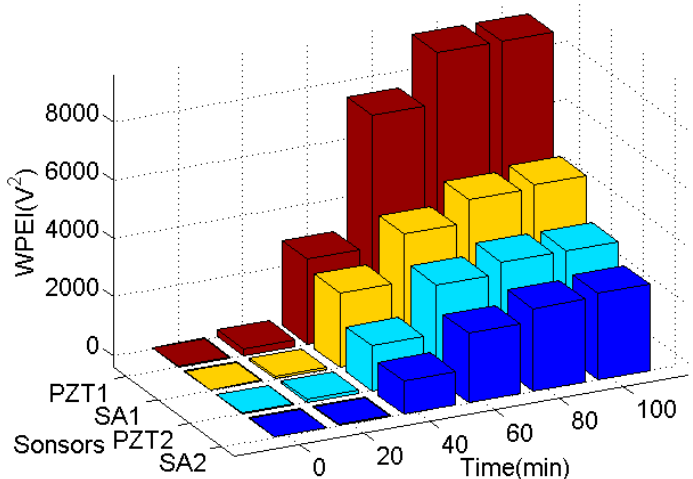
Figure 12. Wavelet-packet-based energy indices (WPEIs) of PZTs and SAs